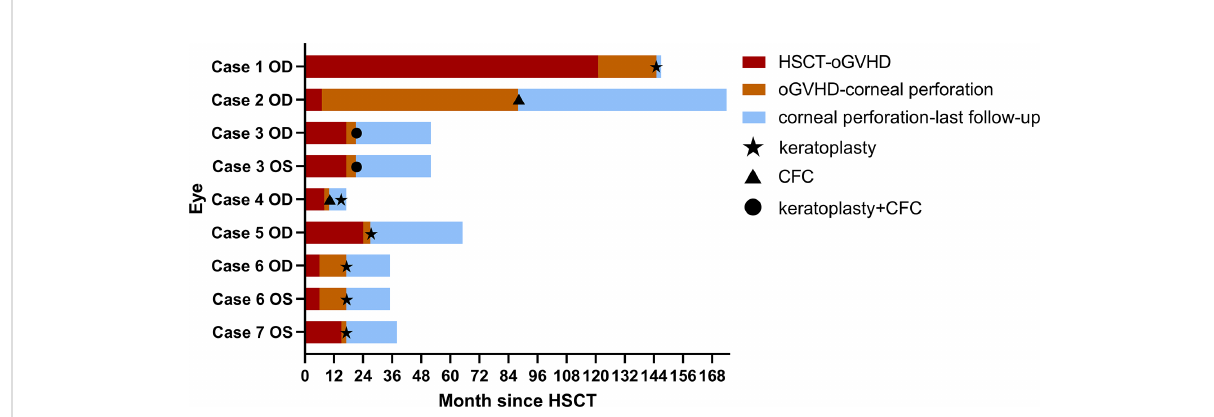
FIGURE 1 Time courses of HSCT, oGVHD diagnosis, corneal perforation, surgeries, and last follow-up in each affected eye of seven patients. The duration between HSCT and oGVHD diagnosis was shown in red. The duration between oGVHD diagnosis and corneal perforation was presented in orange. The duration between corneal perforation and last follow-up in ophthalmology department was shown in blue. Five affected eyes in Cases 1, 5, 6, and 7 underwent keratoplasty surgeries at the time of corneal perforation. The right eye of Case 2 underwent CFC at the time of corneal perforation. Both eyes of Case 3 were found corneal perforation at the same time and accepted keratoplasty and CFC combined surgery. The right eye of Case 4 accepted CFC at the time of corneal perforation and underwent keratoplasty 5 months later because of oGVHD progression during the follow-up. Abbreviations: the right eye (OD), the left eye (OS), hematopoietic stem cell transplant (HSCT), ocular graft-versus-host disease (oGVHD), conjunctival fl ap covering surgery (CFC).